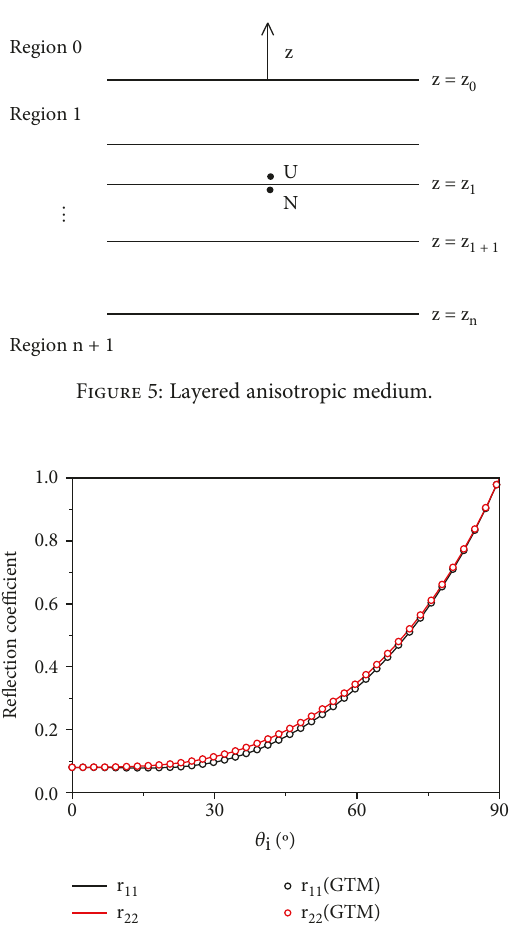
Figure 6: The re fl ection coe ffi cients of the analytic method and the GTM method.